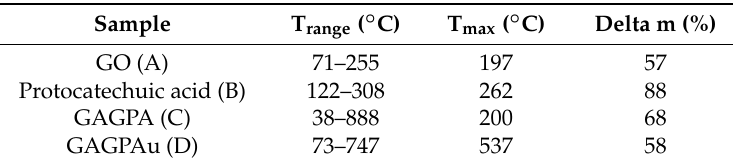
Table 2. Decomposition temperature range (T range ) maximum peak temperature (T max ) and change in mass (Delta